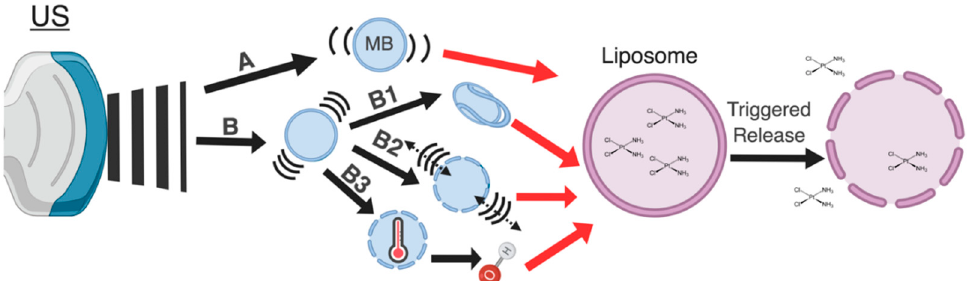
Figure 2. Schematic of the mechanisms associated with US that can be used to mechanically destabilize liposomes. The mechanisms are as follows: ( A ) US induced stable cavitation of a MB ( B ) US induced inertial cavitation of a MB; ( B1 ) The production of a liquid microjets from a MB undergoing inertial cavitation; ( B2 ) The production of shockwaves from a MB undergoing inertial cavitation; ( B3 ) A MB collapsing and undergoing sonochemical changes.